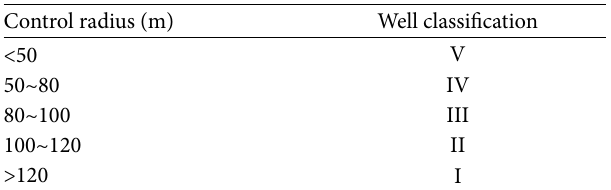
Table 5: The classification standard of wells based on control ra-